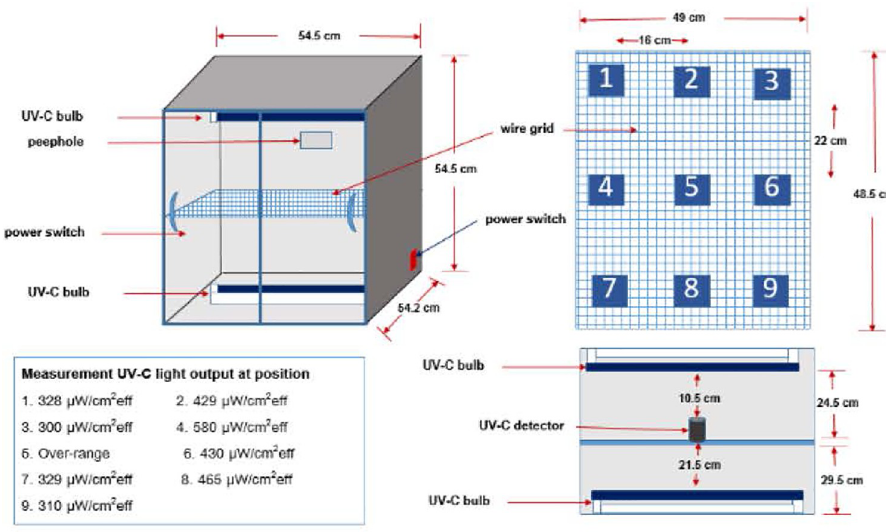
Fig 6. Lighting platform, measuring UVC light at different locations within the